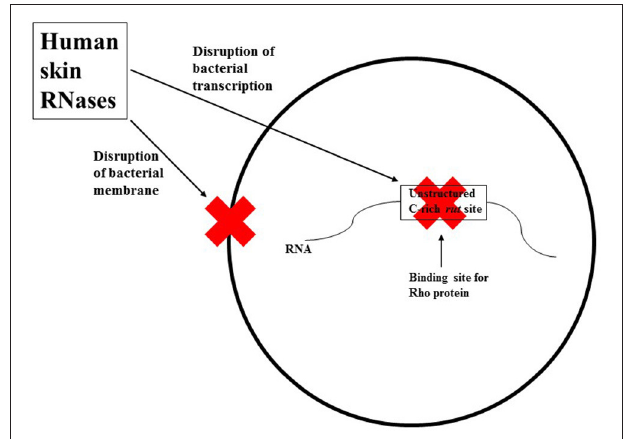
FIGURE 1 | A simplified schematic representation of the two mechanisms human skin RNases may employ against invading bacteria. These RNases may bind to and disrupt bacterial membranes, and/or may enter the bacteria and disrupt their transcription process by cleaving the rut site (unstructured C-rich sequences) in nascent bacterial